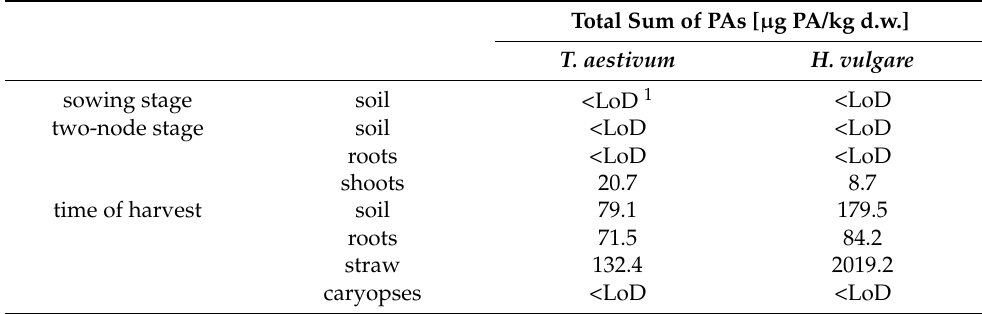
Table 7. PA-content of T. aestivum and H. vulgare growing in pots with surface soil from L. squarrosa fields of the previous year.